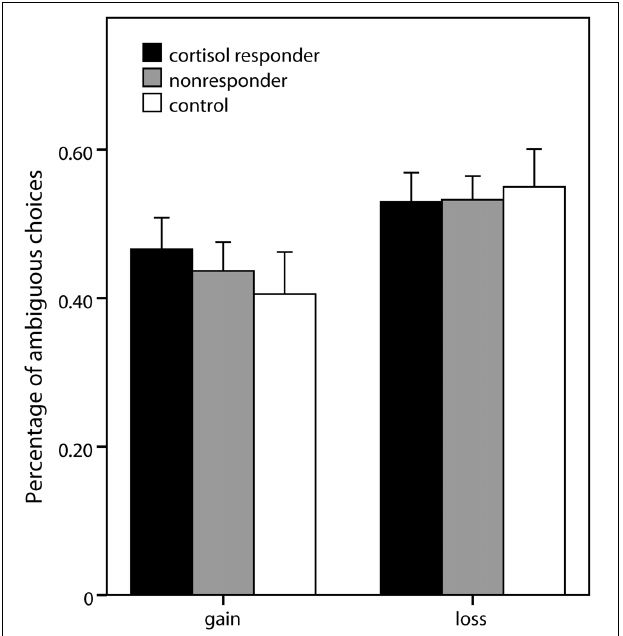
FIGURE 5 | Ambiguous choices in the decision task. Percentage ( ± s.e.m.) of choices of the ambiguous option (vs. risky lotteries) in the two domains of the ambiguity part of the decision making